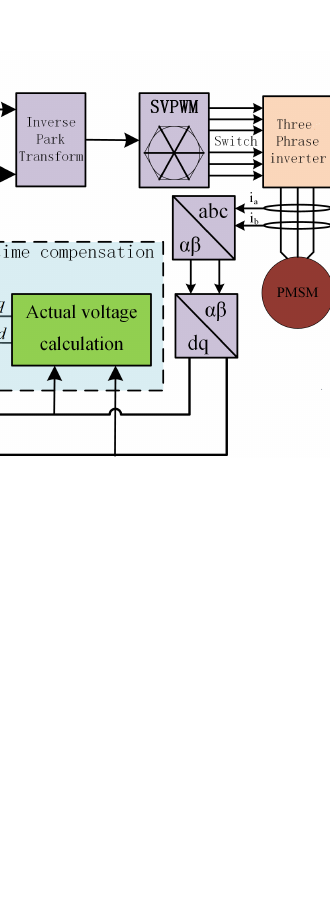
Figure 4. The actual voltage calculation